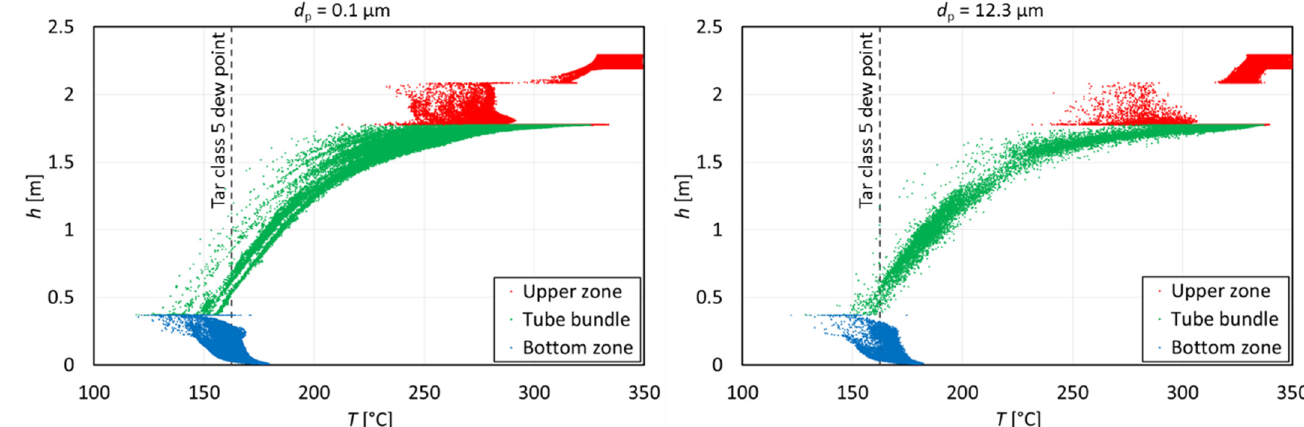
Figure 10. Particle impacts along with the heat exchanger height as a function of impact temperature, for particles with a diameter of 0.1 μ m and 12.3 μ m (tar class 5).